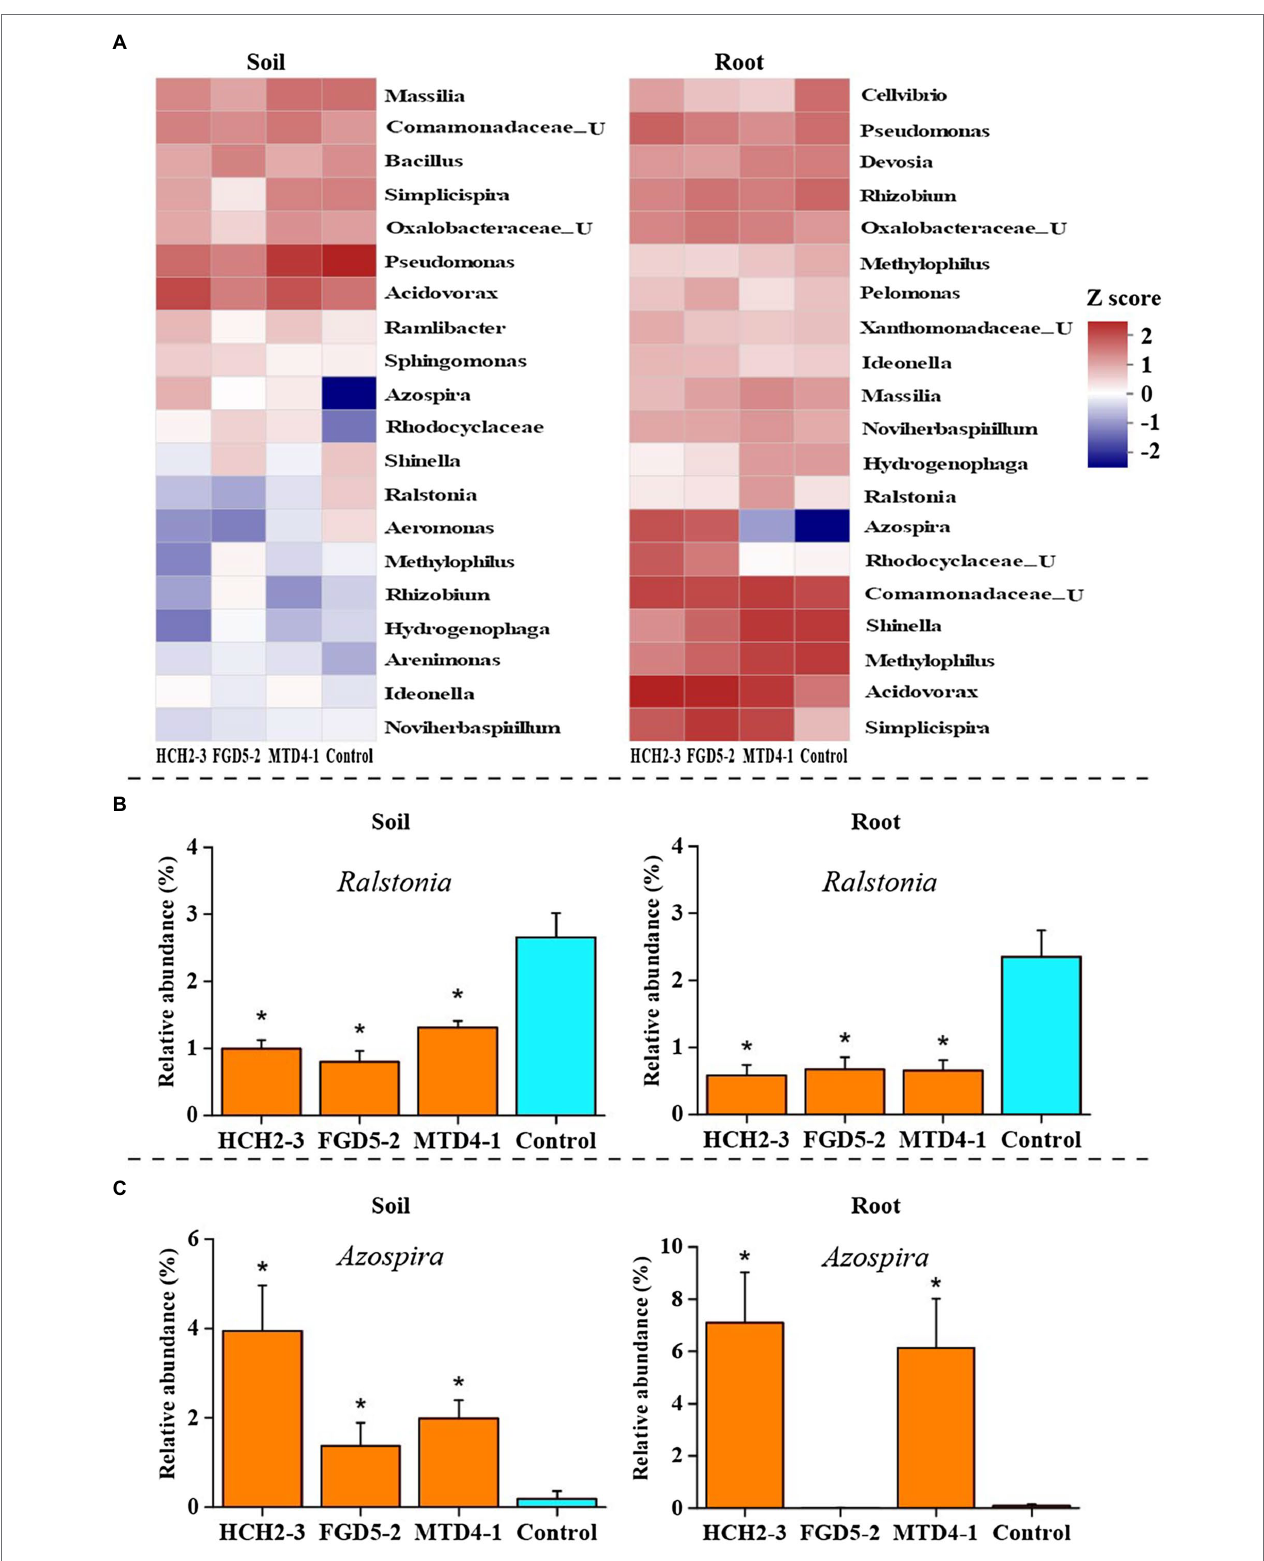
FIGURE 3 | Changes in rhizosphere bacterial community composition in different samples. Bacterial community composition in soil and root samples at the